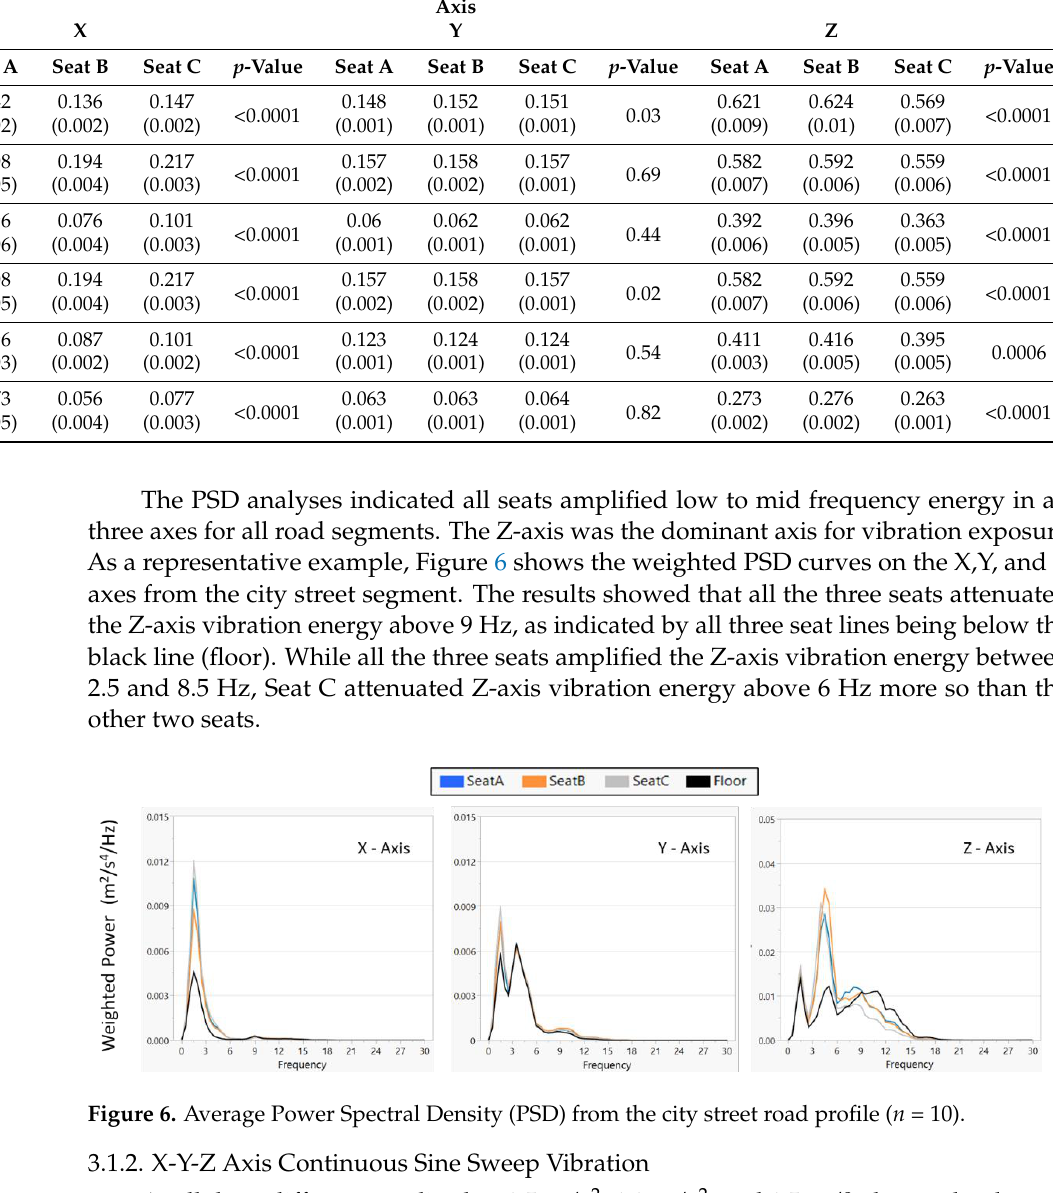
Figure 6. Average Power Spectral Density (PSD) from the city street road profile ( n = 10).